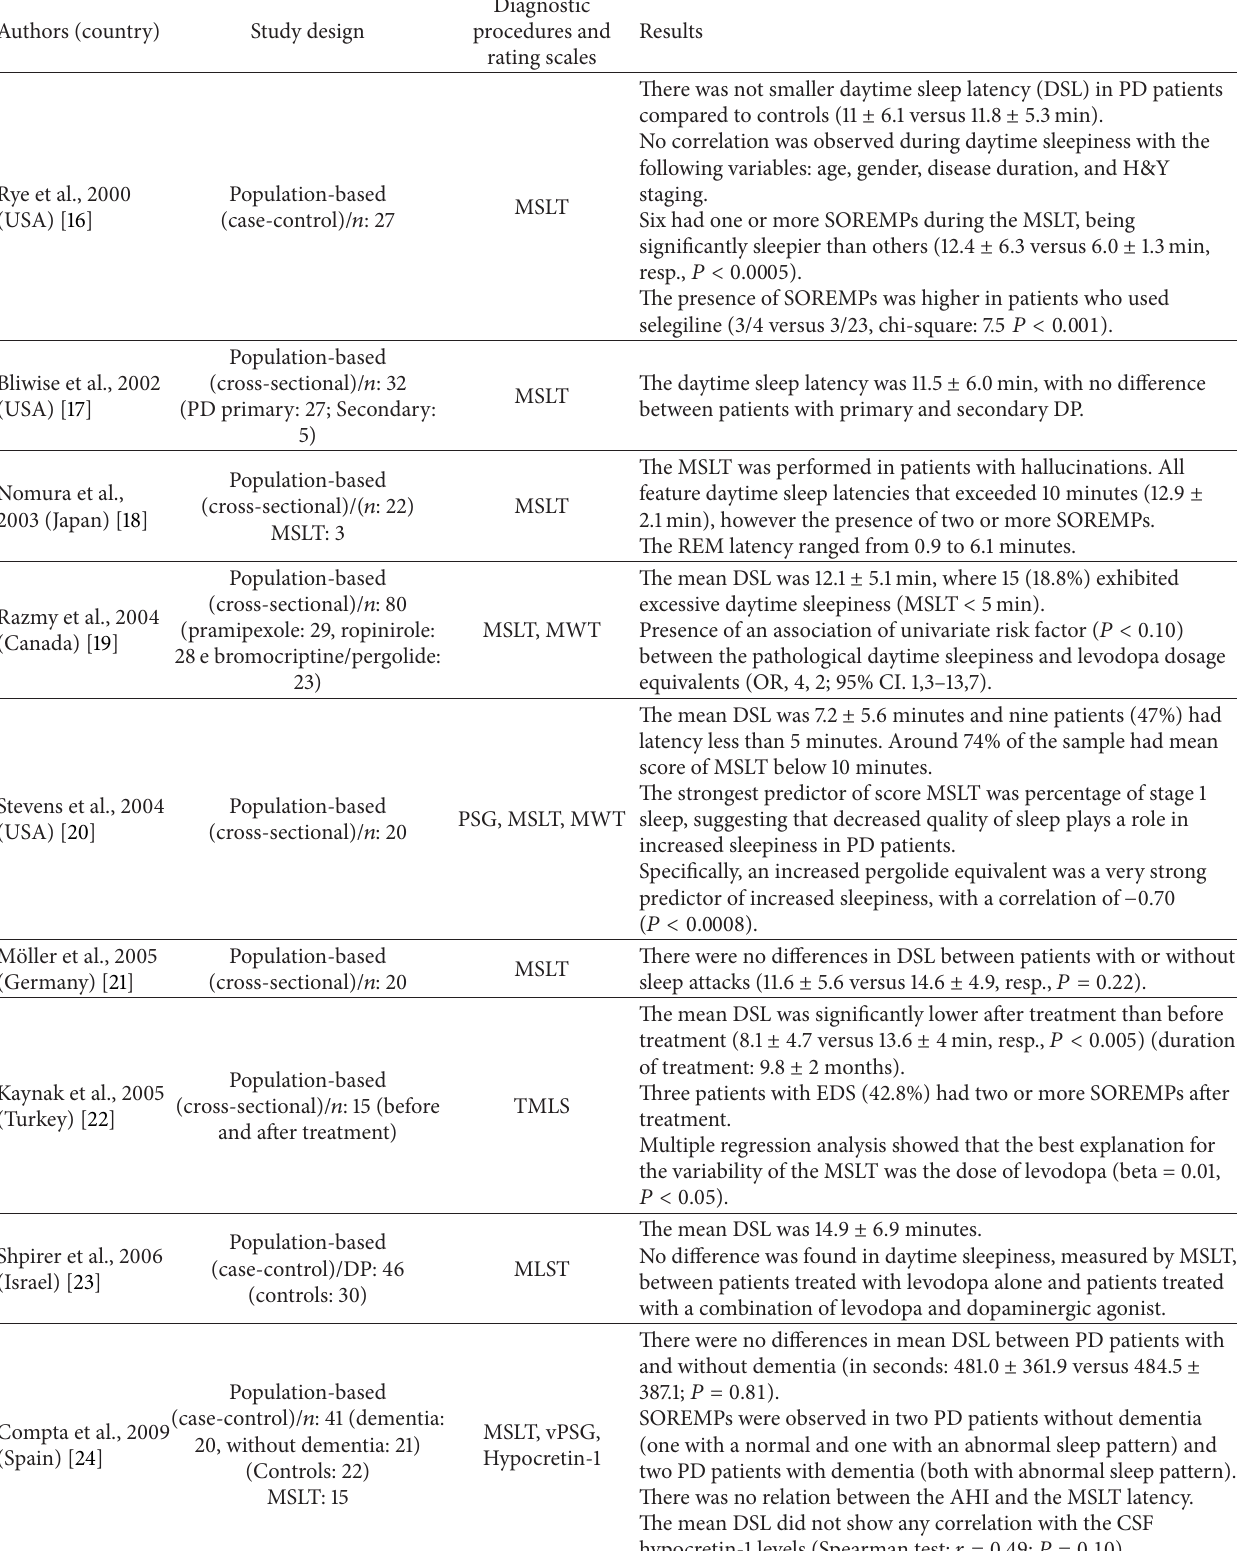
Table 1: Characteristics and results of MSLT studies in patients with Parkinson’s disease without complaints of sleepiness ( 𝑛 : 14). Authors (country) Study design